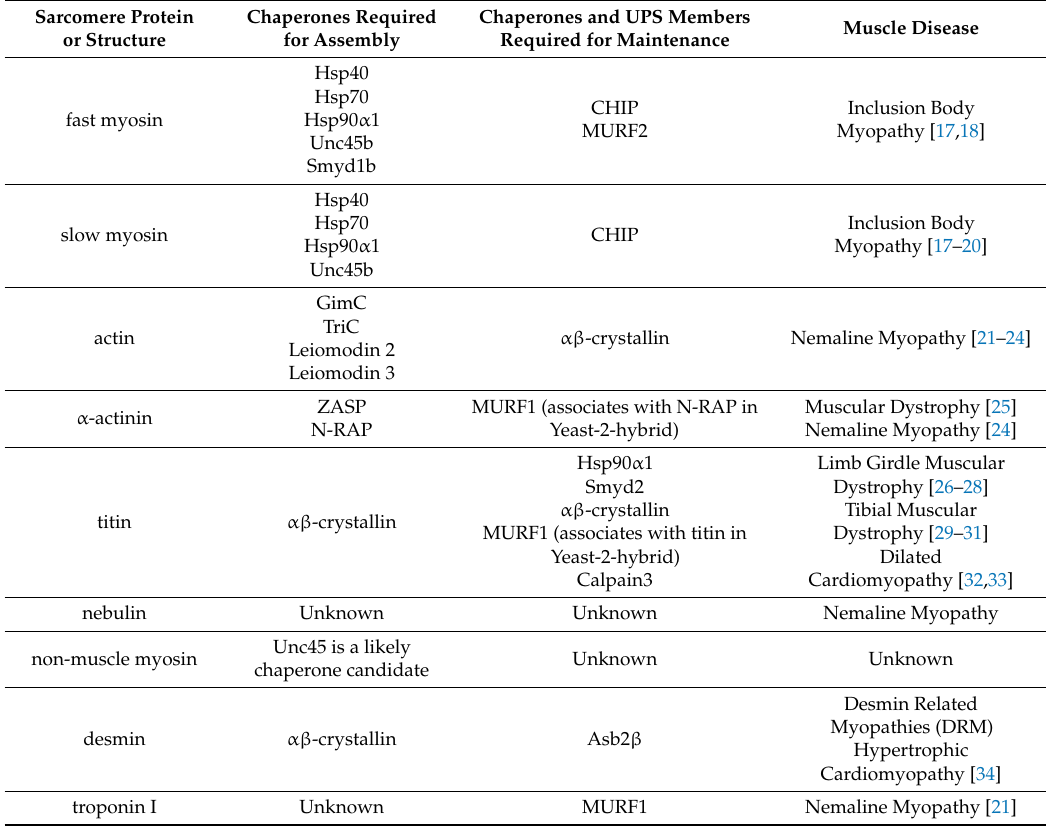
Table 1. Sarcomere protein with assembly and maintenance factors and associated